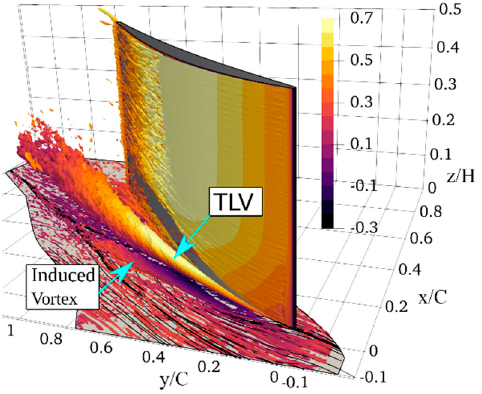
→ Figure 11. Vortical structure (λ (cid:2870) (〈v(cid:4652)⃗〉) = −2) for the linear compressor cascade at Re (cid:2913) = 3 ⋅ 10 (cid:2873) . Figure 11. Vortical structure ( λ 2 ( v ) = − 2 ) for the linear compressor cascade at Re c = 3 · 10 5